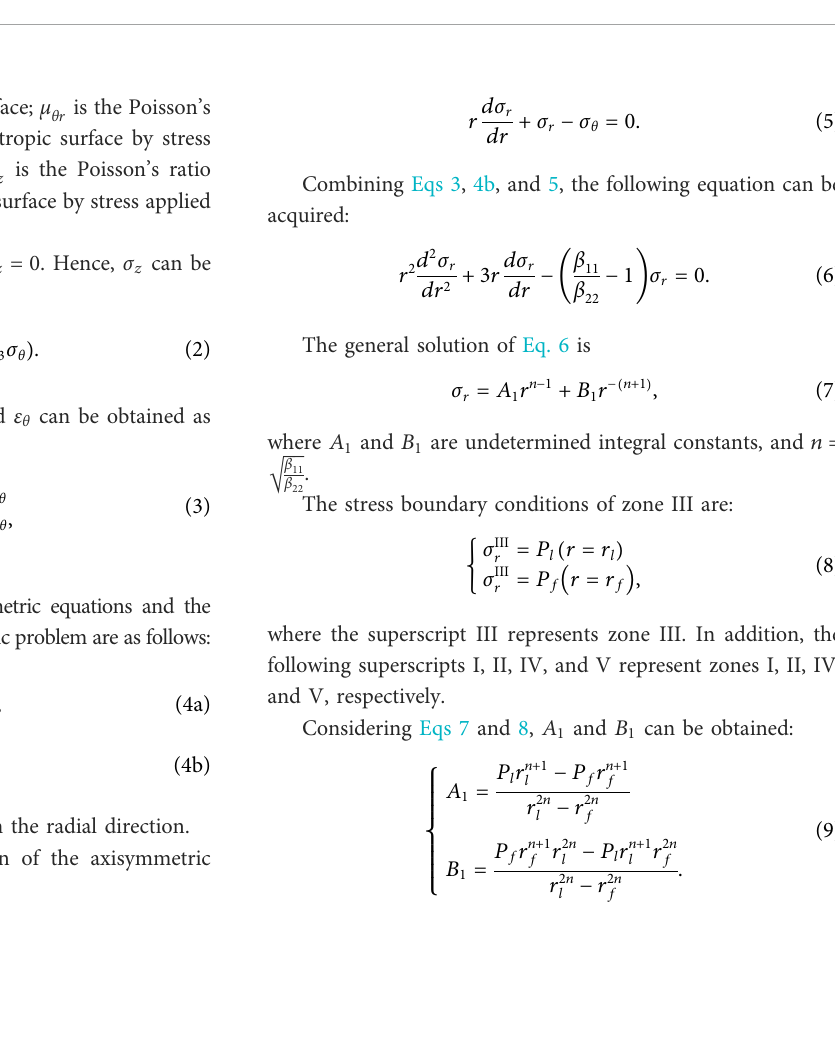
FIGURE 5 Mechanical model of cold region